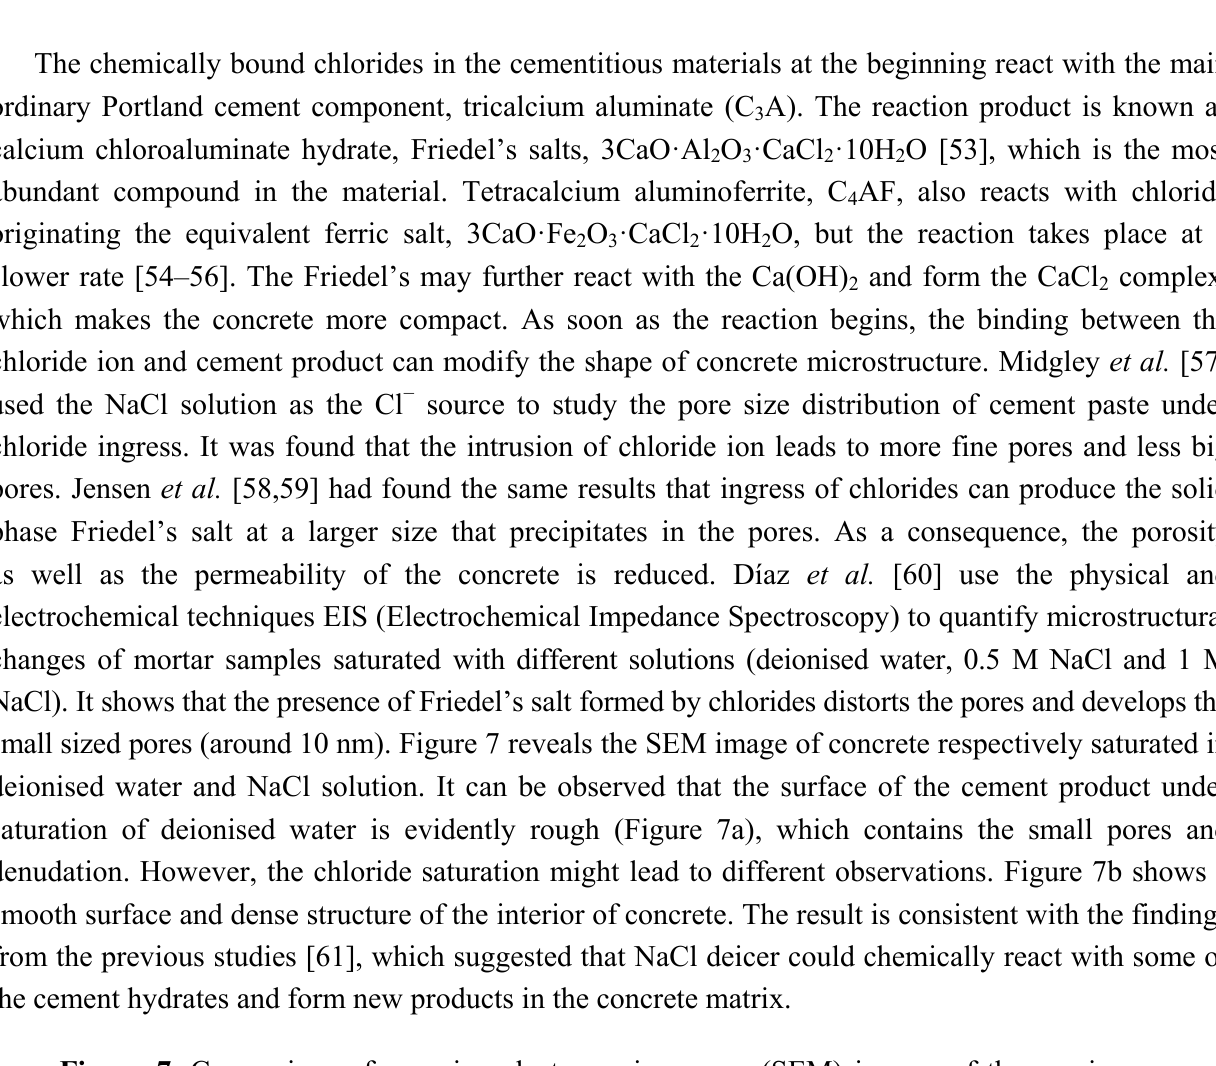
Figure 7. Comparison of scanning electron microscopy (SEM) images of the specimens immersed with different solutions: ( a ) Saturated in deionised water; ( b ) Saturated in NaCl